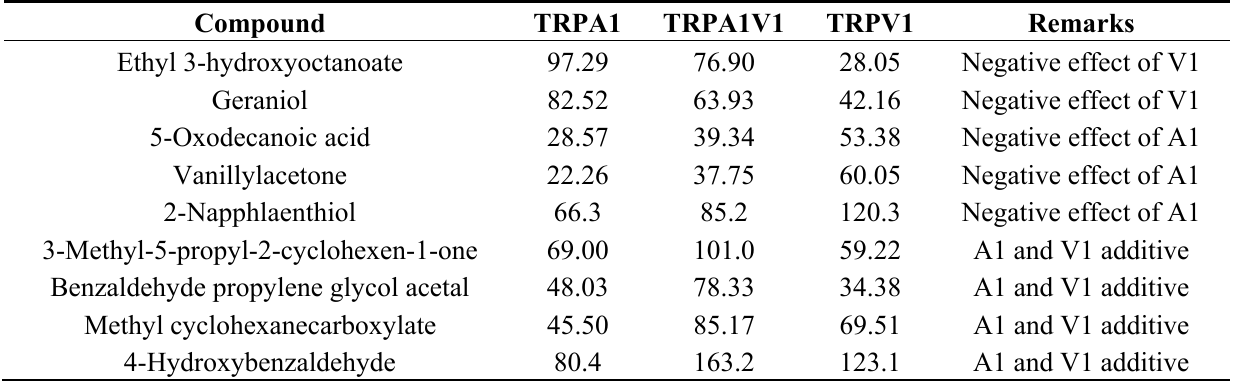
Table 1. Examples of compounds that activated all three receptors with TRPA1V1 showing differential modulation.